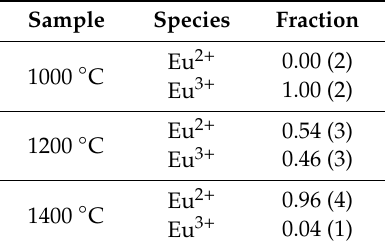
Table 3. Results of the linear combination fitting at the Eu 2 + and Eu 3 + L 3 -edge WLs for the XANES spectra of the CAO: Eu, Nd particles synthesized at 1000, 1200, 1400 ◦ C for 2 h in a 90N 2 -10H 2 atmosphere, employing a salt / CAO molar ratio of 3:1, alumina platelets with an average particle size d 50~ 6 µ m, and using an Al 2 O 3 / CAO molar ratio of 1.